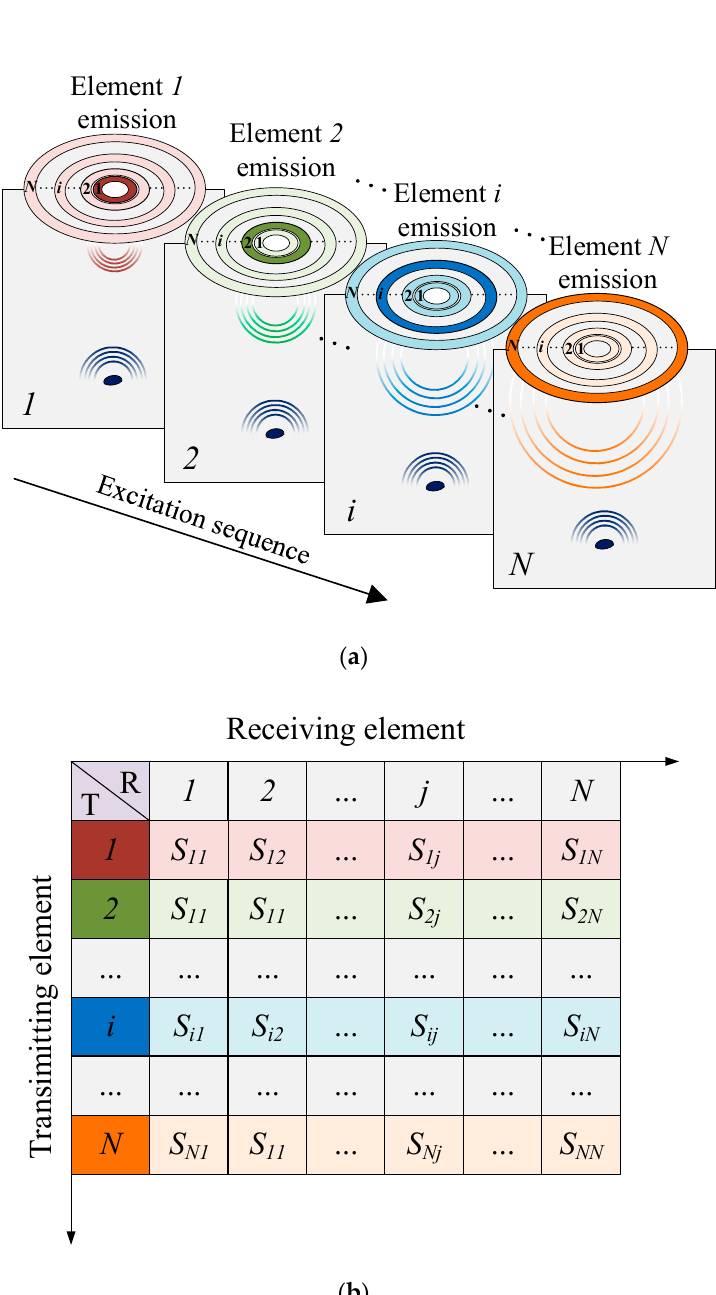
Figure 2. Full matrix data capturing of annular array transducer; ( a ) schematic of data capturing, ( b ) full matrix data obtained from N elements.